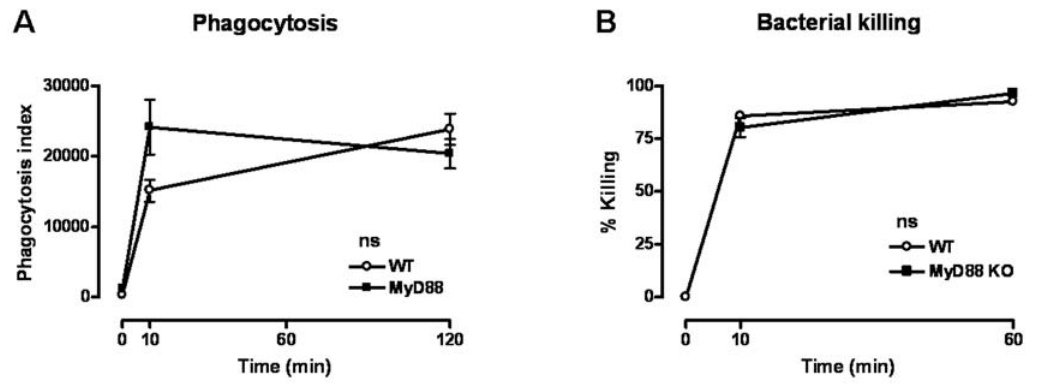
Figure 7. No difference in B.pseudomallei phagocytosis or killing capacity between WT and MyD88 KO cells. (A) Peripheral blood neutrophils were incubated at 37 u C with CFSE-labeled growth-arrested B. pseudomallei (1 6 10 7 CFU/ml) after which time-dependent phagocytosis was quantified; 1 6 10 4 neutrophils were analysed per sample (see Methods section). (B) Killing capacity of peritoneal macrophages are shown as percentage of killed B. pseudomallei compared to t=0. Data are mean 6 SEM; n=5 per mouse strain. Open rounds represent WT cells, while black squares represent MyD88 KO mice; ns denotes not significant.